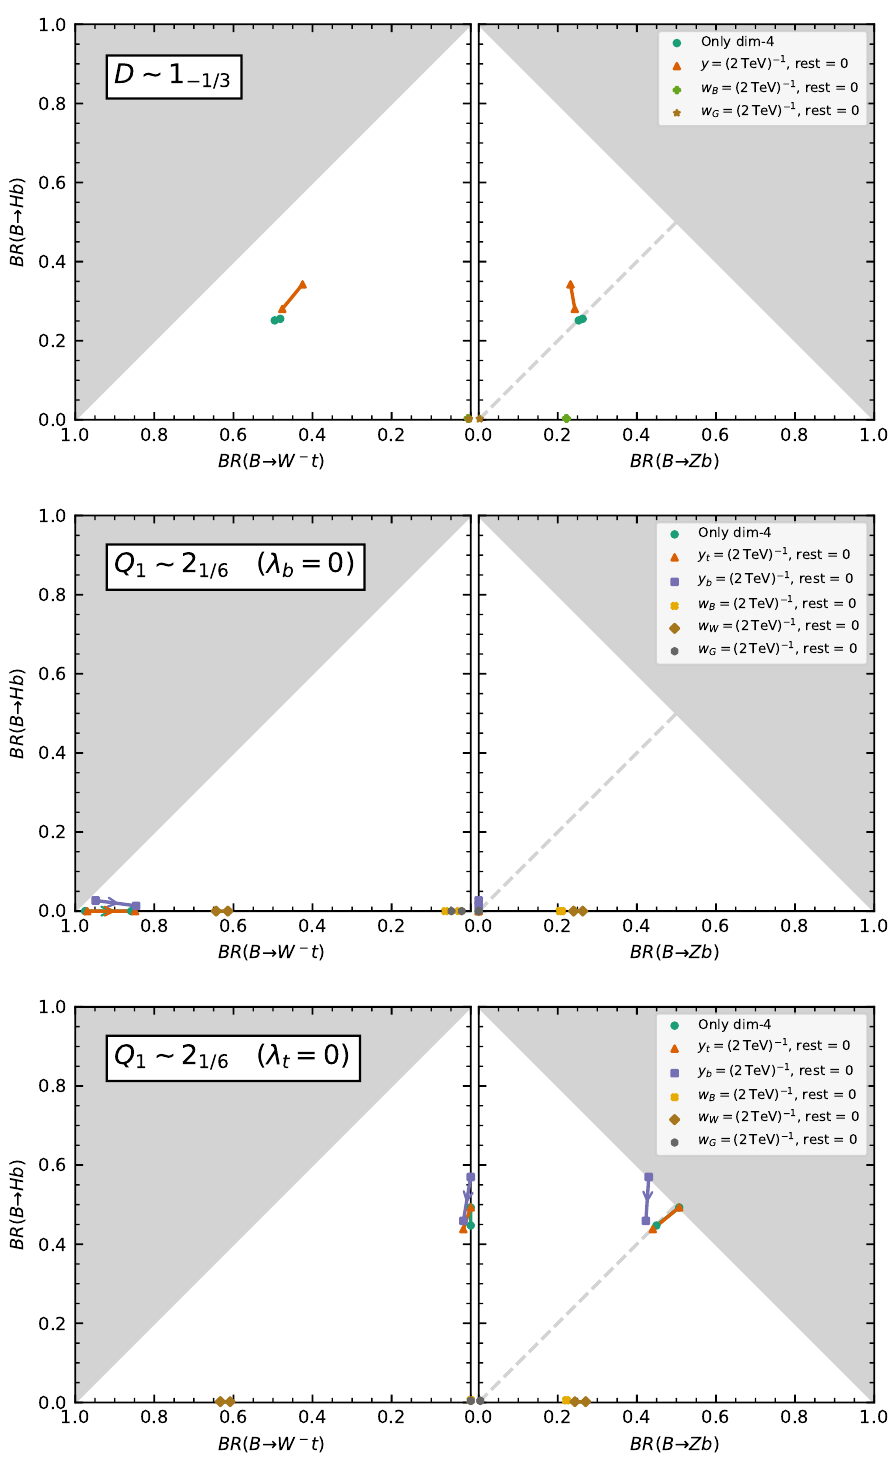
Figure 12 . Branching ratios of B into Hb , Zb and W (cid:0) t for various values of the parameters in the D and Q 1 models. The dimensionless couplings (cid:21) are always chosen to saturate the corresponding electroweak precision bounds.